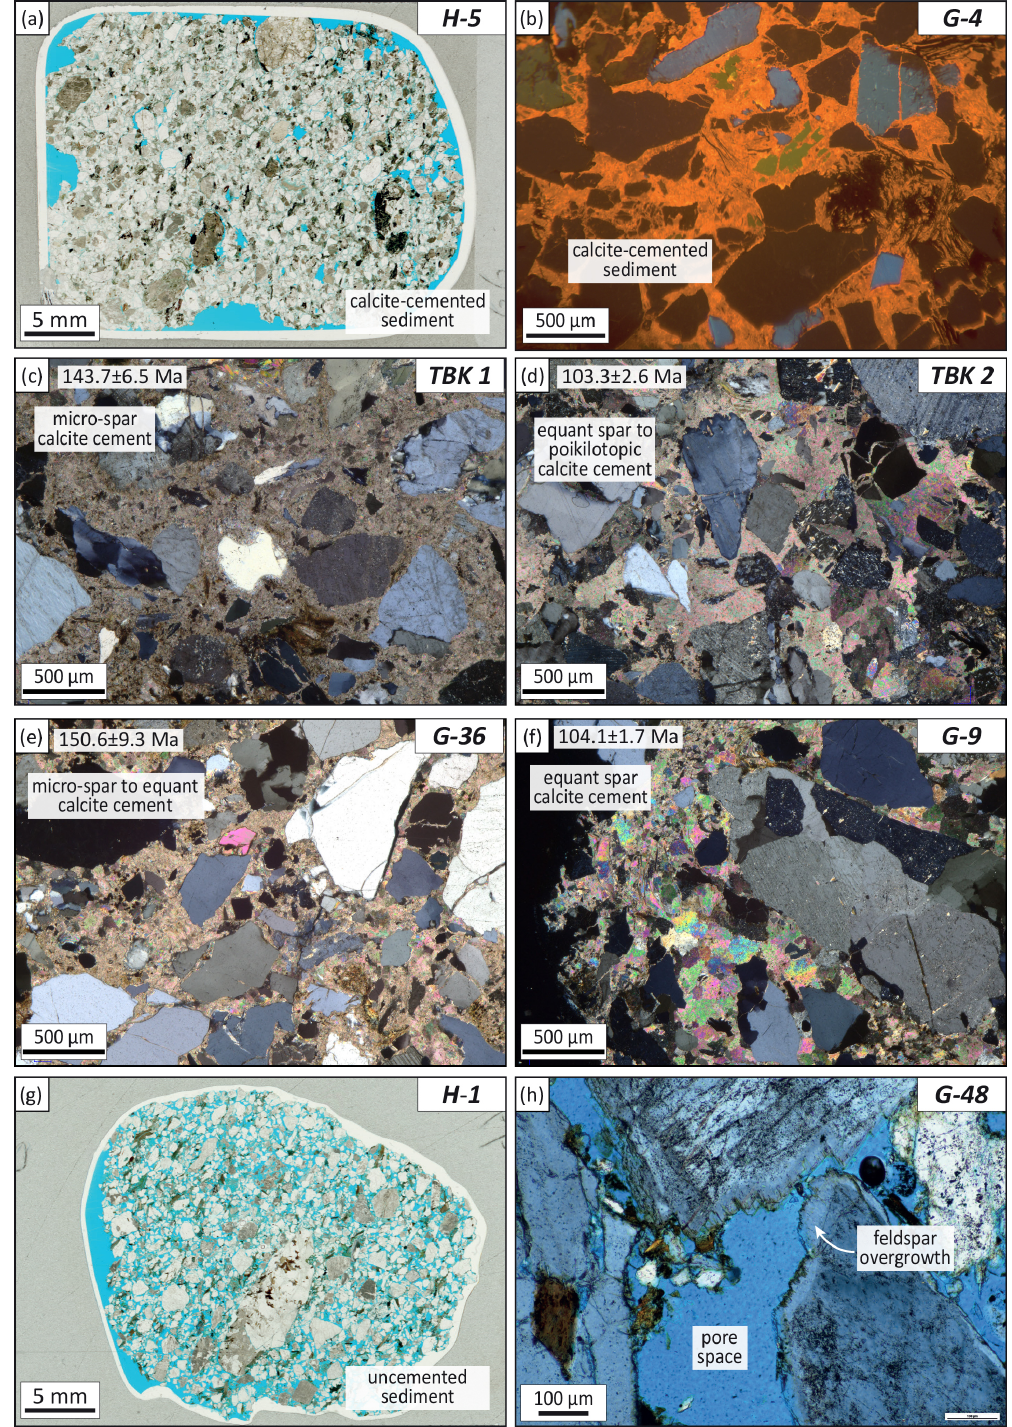
Figure 4. Thin section photos of hanging wall sediments (sample ID in the respective upper right corner). (a) Calcite-cemented sample H-5 (plane-polarized light (PPL); oversized pores are caused by plucked grains during sample preparation); (b) cathodoluminescence image of calcite-cemented sample; (c–f) close-up of pore-filling calcite cements with textures ranging from micro-spar to poikilotopic cement (cross- polarized light); (g) calcite-free sediment sample H-1 (PPL); (h) close-up of calcite-free sample with common feldspar overgrowth (XPL with 1 / 4 λ